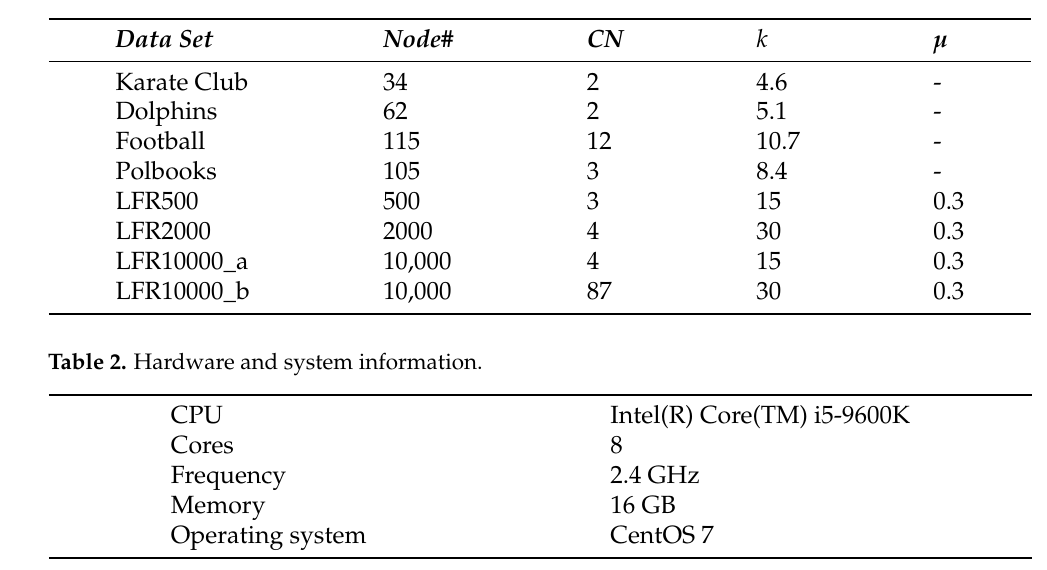
Table 1. Main properties of data sets.